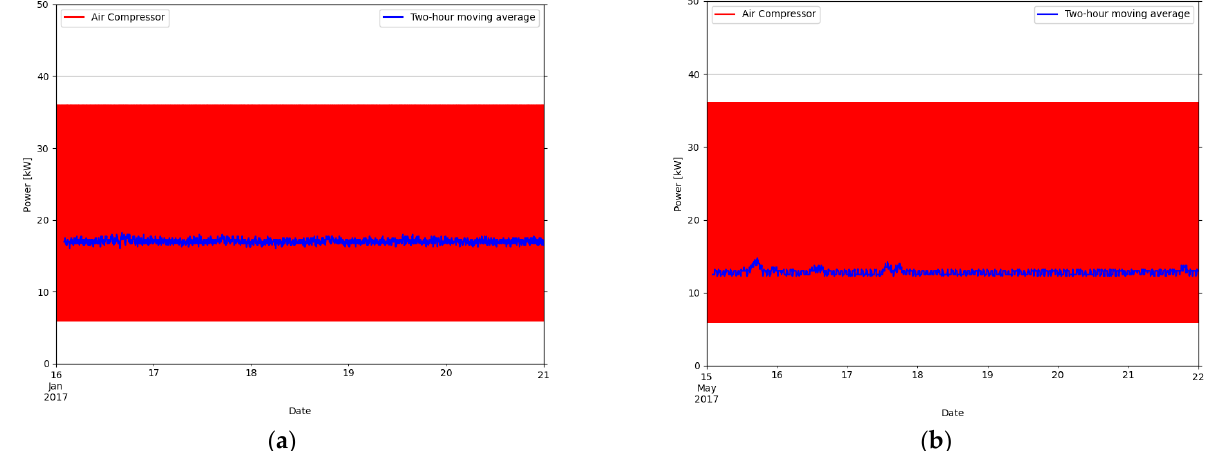
Figure 6. Up sampled power data for the Air Compressor and two-hour moving average, ( a ) Training Period, ( b ) Test Period.